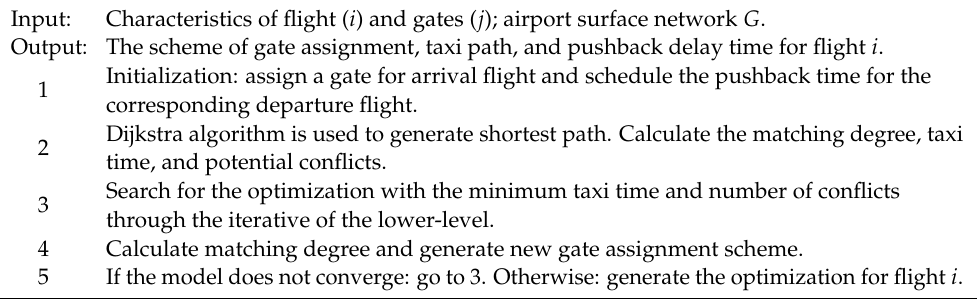
Algorithm 1 . Bilevel programming method for joint ground movement optimization for flight i